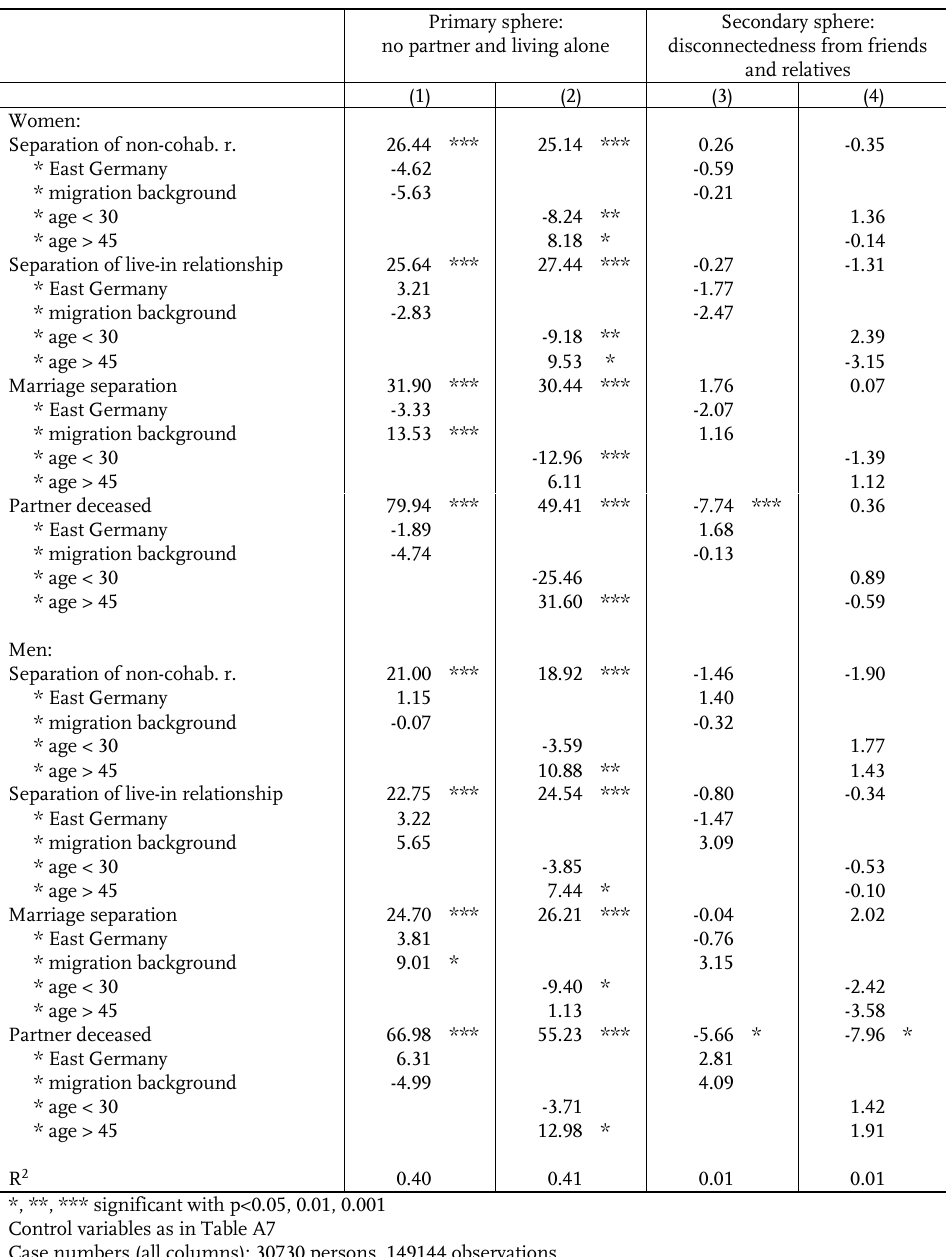
Table A.12 : Moderation of effects of relationship endings by region, migration background, and age (linear- probability models with fixed effects, percentage points) Primary sphere: Secondary sphere: no partner and living alone disconnectedness from friends and